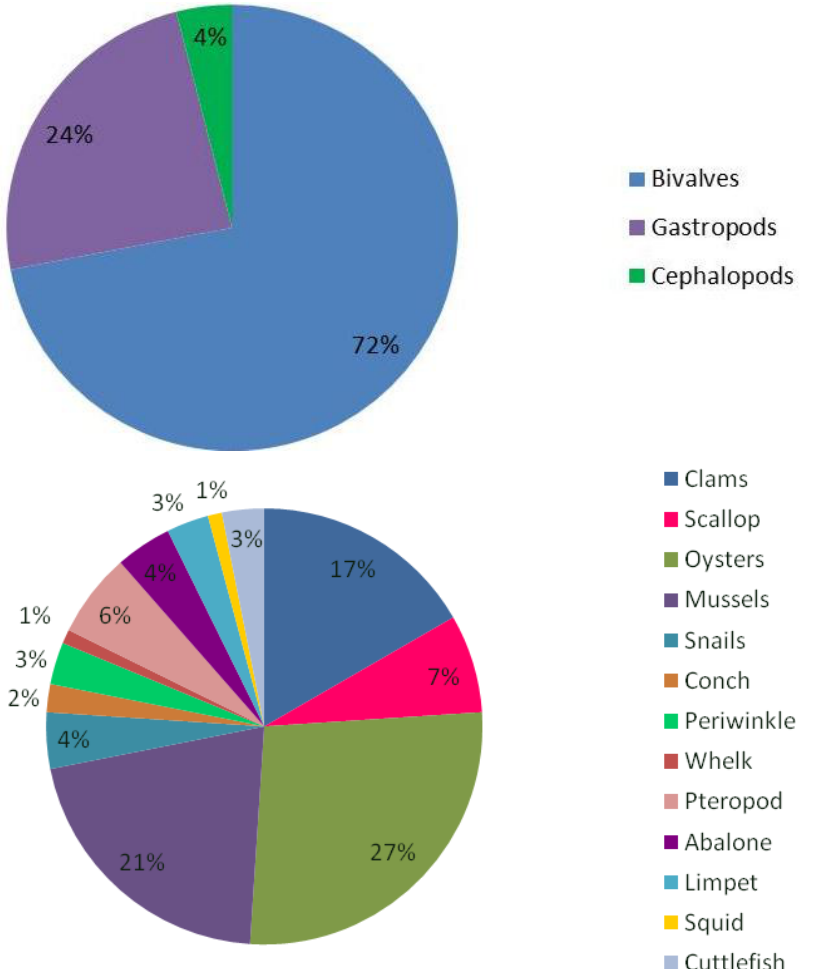
Figure 1. Proportion of studies (as a percentage) done on each mollusc